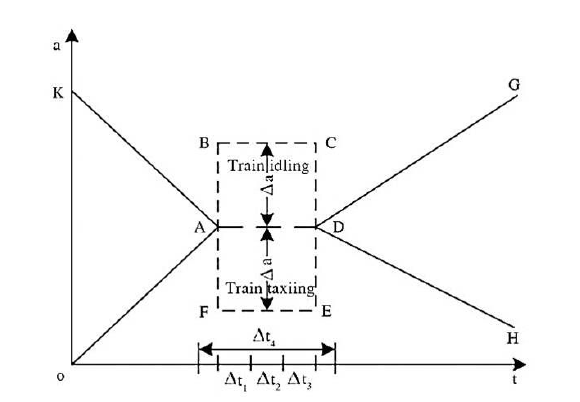
Figure 5: Schematic diagram of idling/gliding acceleration detection